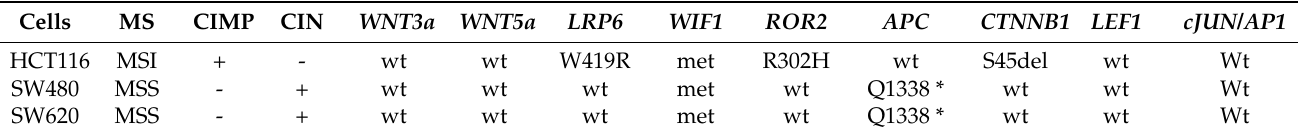
Table 2. Cell line characteristics and WNT mutation